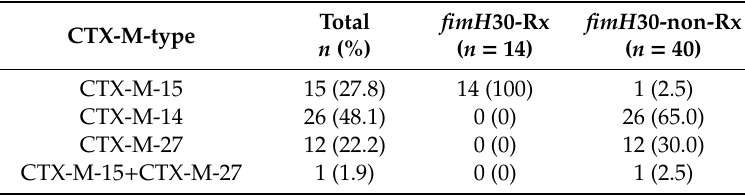
Table 3. Subclones and CTX-M type of ESBL-producing E. coli CH40-30 (ST131- fimH30 ) in 54 isolates.